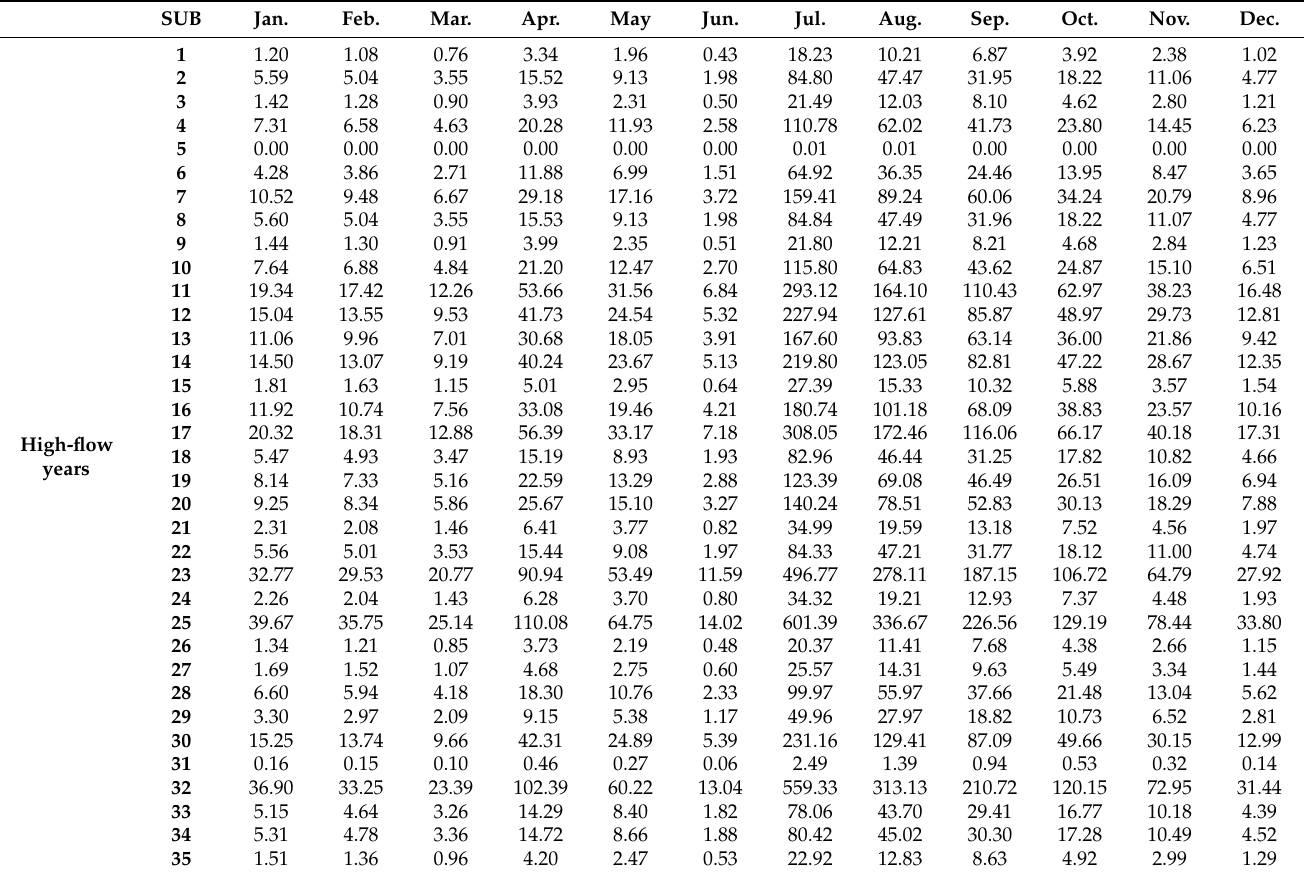
Table A1. Early warning value of upper limit of NH 3 -N monthly emission in each sub-basin in different level years